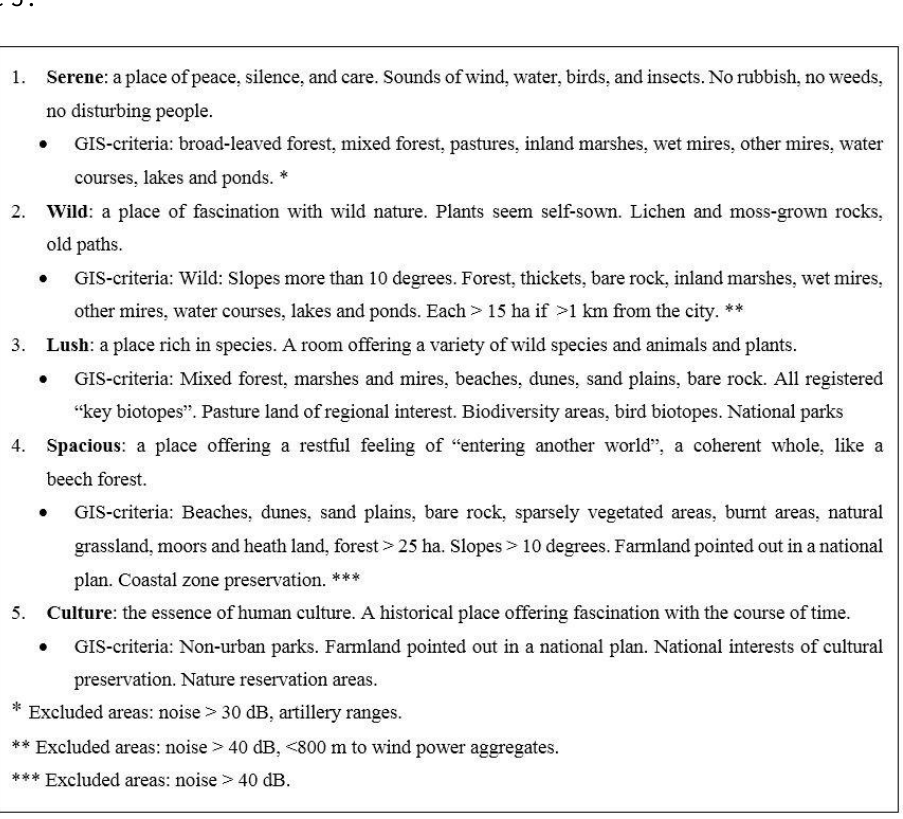
Figure 3. Description of the perceived sensory dimensions of the recreational nature qualities and corresponding GIS-definitions. The decibel criteria only relates to disturbing noise, such as traffic, but not absolute sounds levels from, for example, twittering birds and other nature